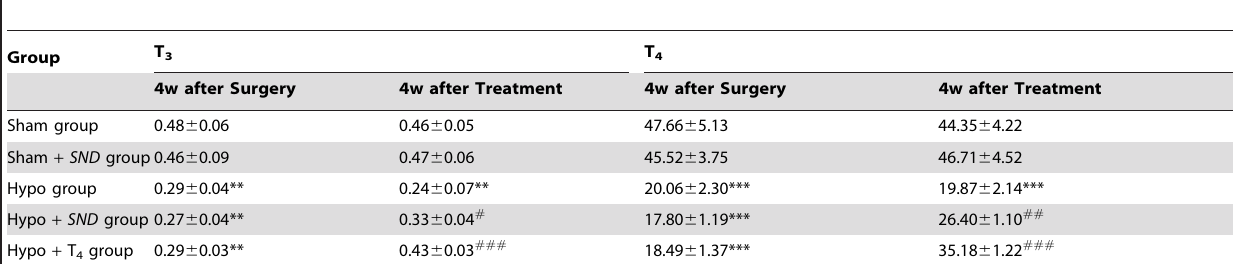
Table 1. Sample determination of total triiodothyronine (T 3 ) and total thyroxine (T 4 ) in rat serum for the surgery-induced hypothyroid groups (mean 6 S.D.) a (n=8).